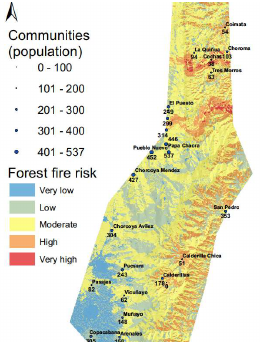
Figure 9. Communities and forest fire risk